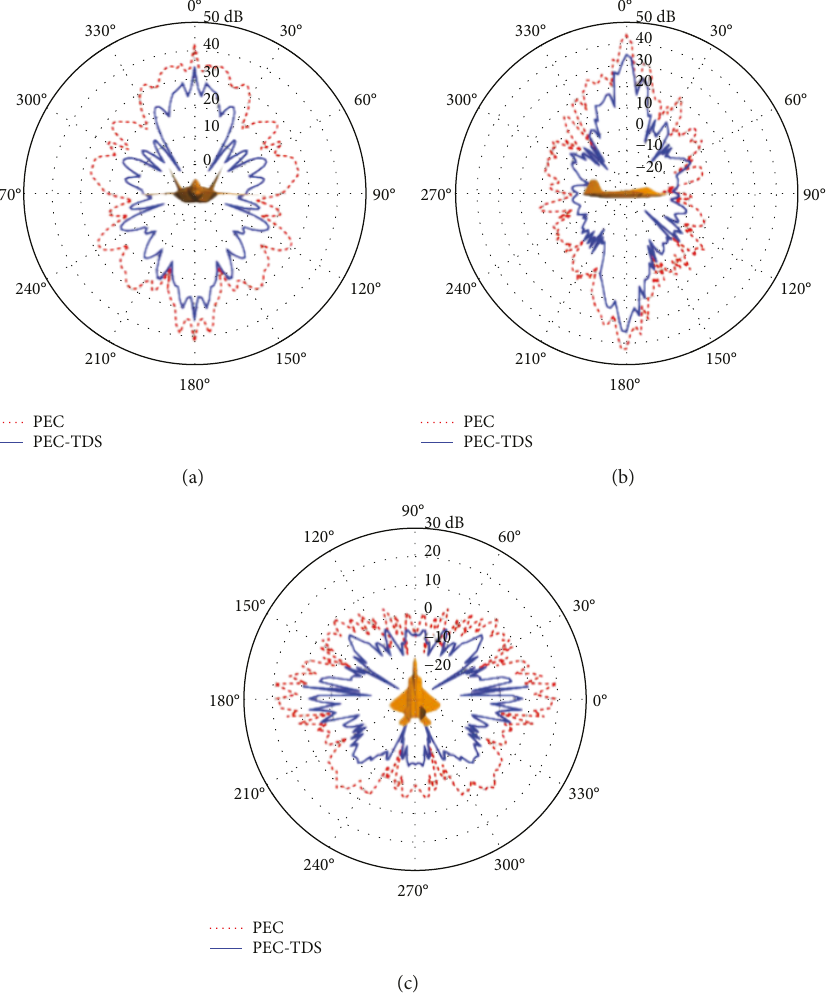
Figure 5: Monostatic RCS of a dielectric coated aircraft for theta-polarization. (a) xz plane. (b) yz plane. (c) xy